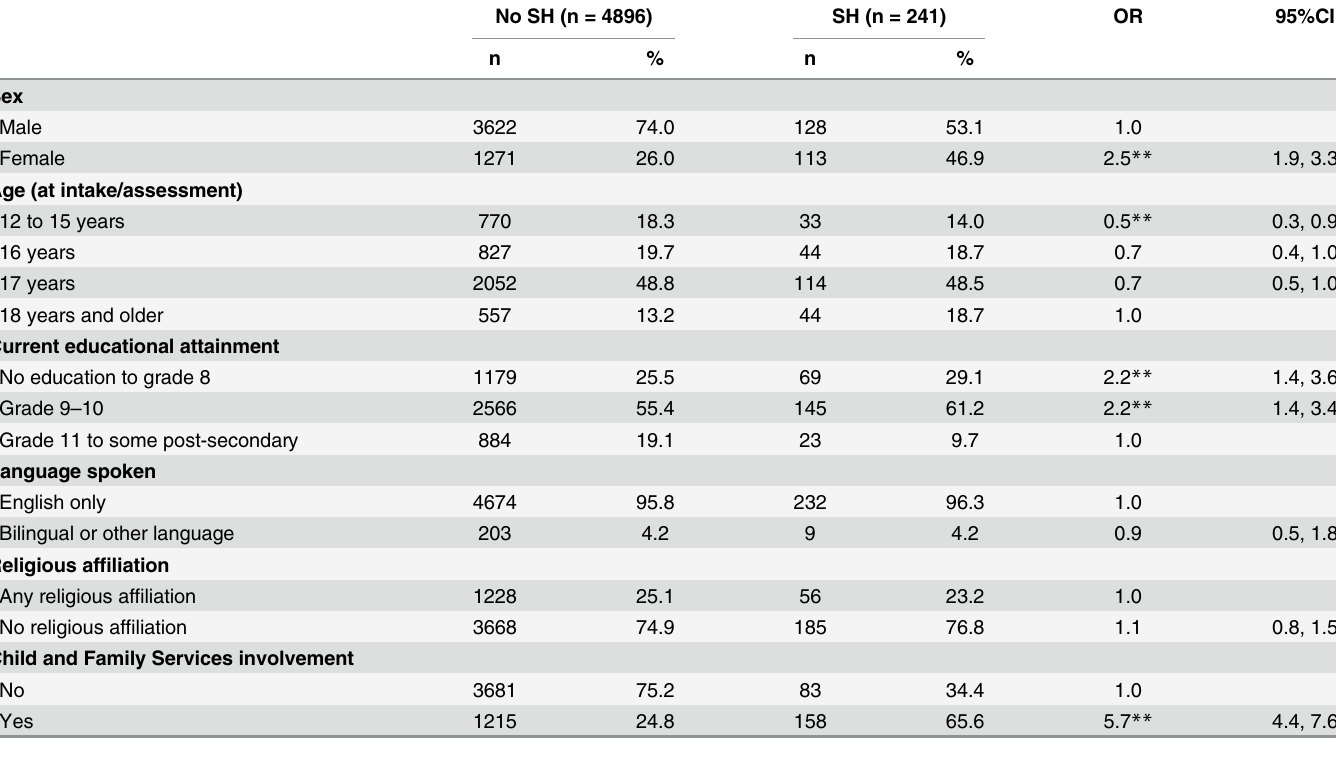
Table 1. Demographic correlates of self-harm while in youth custody during most recent incarceration. No SH (n =